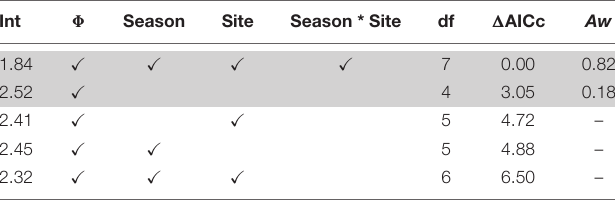
TABLE 2 | Factors influencing the total number of fruits encountered on a